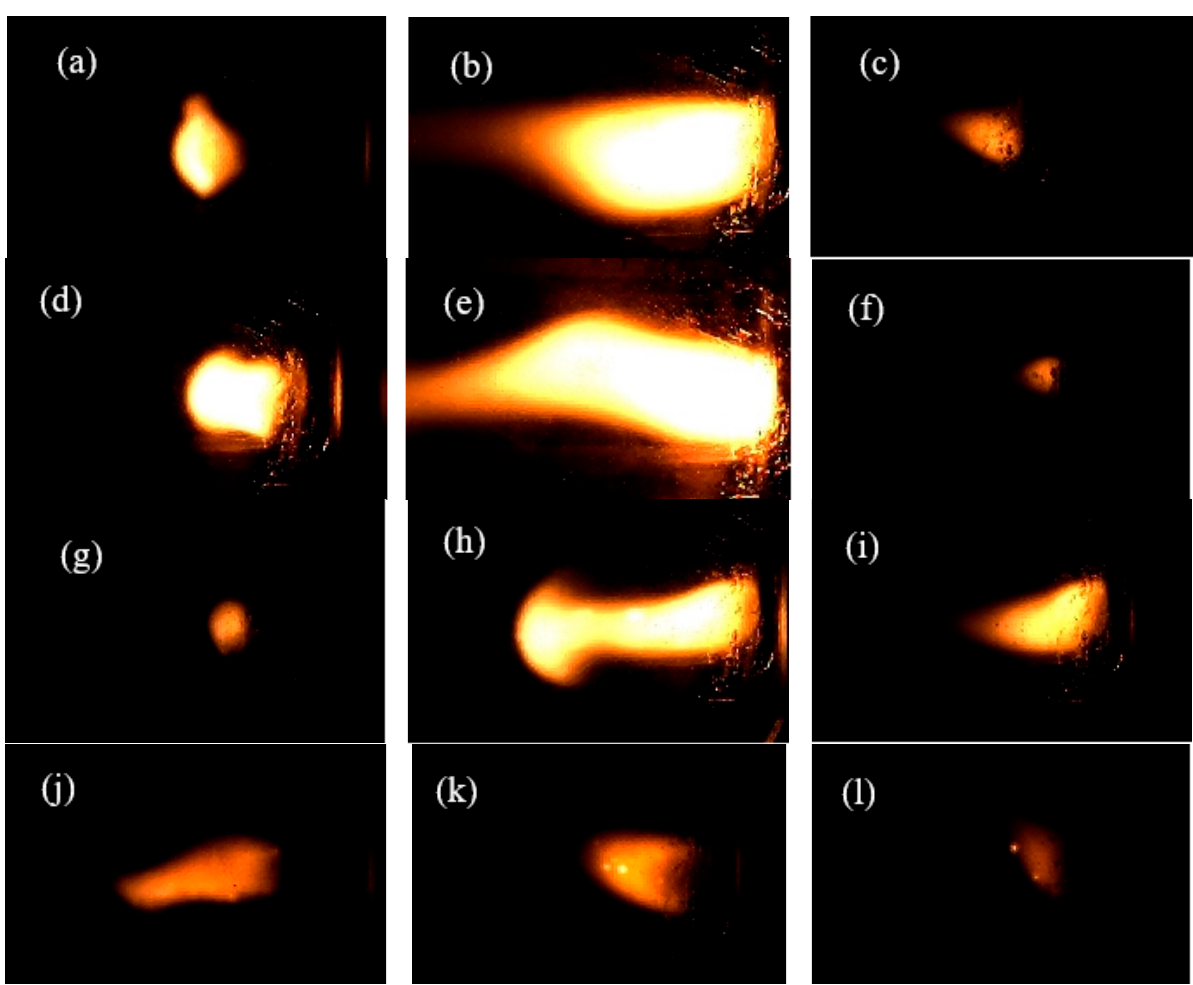
Figure 8. The burning snapshots of samples 1, 2, 3, and 4 under normal air pressure at laser power 40 W: ( a ) sample 1, 15 ms; ( b ) sample 1, 39 ms; ( c ) sample 1, 70 ms; ( d ) sample 2, 9 ms; ( e ) sample 2, 40 ms; ( f ) sample 2, 70 ms; ( g ) sample 3, 9 ms; ( h ) sample 3, 22 ms; ( i ) sample 3, 40 ms; ( j ) sample 4, 33 ms; ( k ) sample 4, 65 ms; ( l ) sample 4, 93 ms.